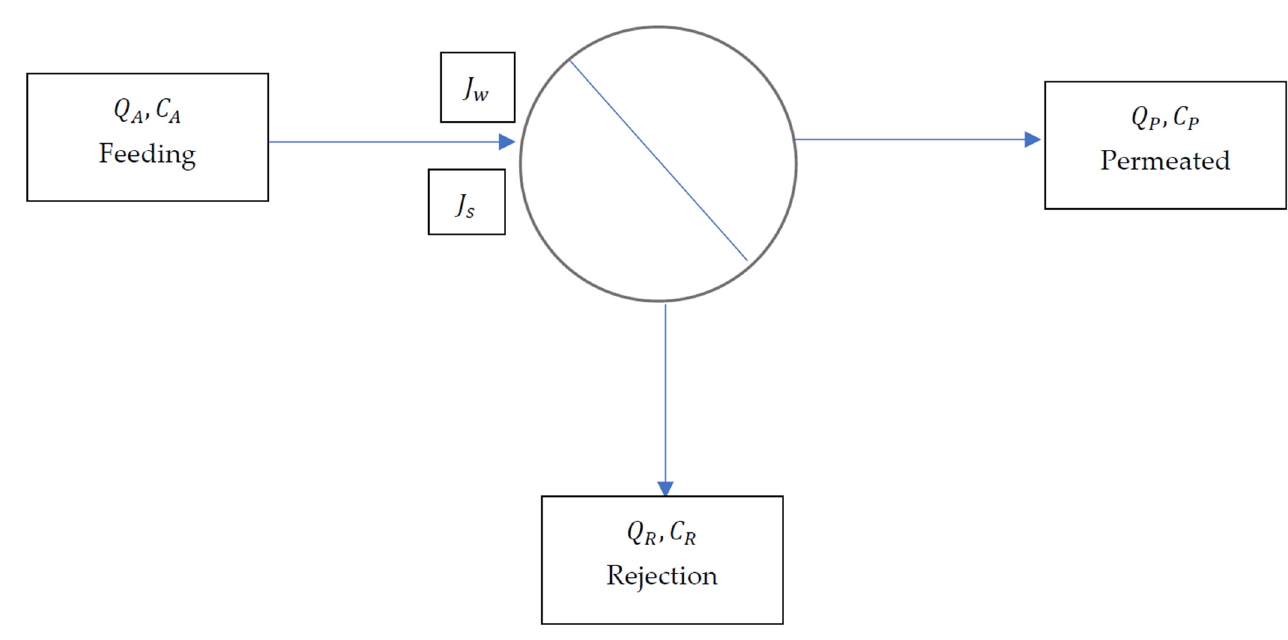
Figure 1. Simplification of the desalination process [30] .